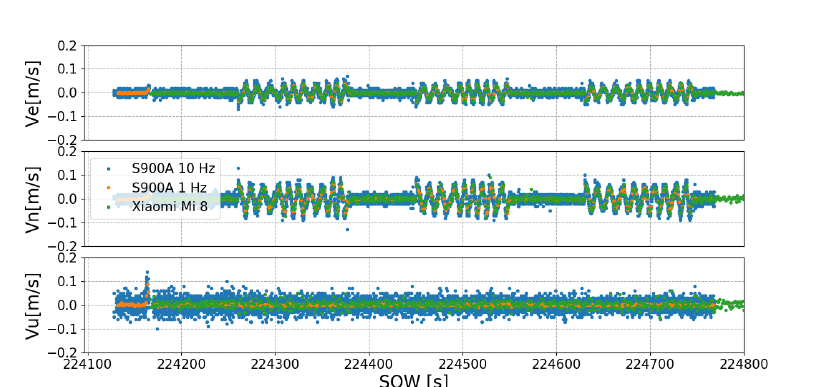
Figure 6. Skyplot containing elevation and azimuth dependance of the C/No value for STONEX S900A ( left ) and Xiaomi Mi 8 ( right ).